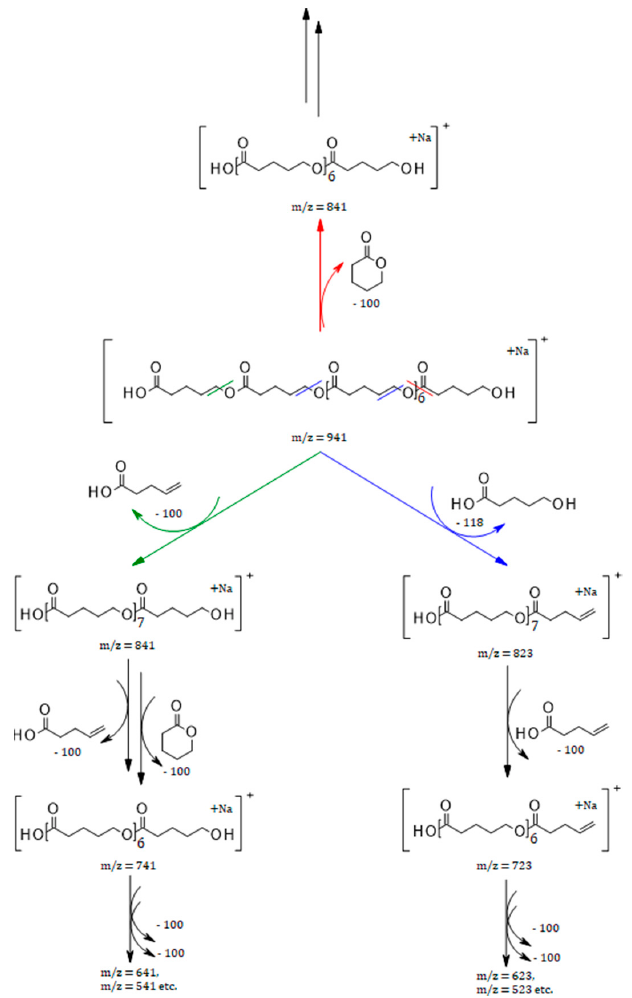
Figure 5. ESI ‐ MS/MS spectrum of the sodium adducts poly( δ ‐ valerolactone) oligomers with hydroxyl and carboxyl end groups at m/z 941 (Sample 1, Table 1).